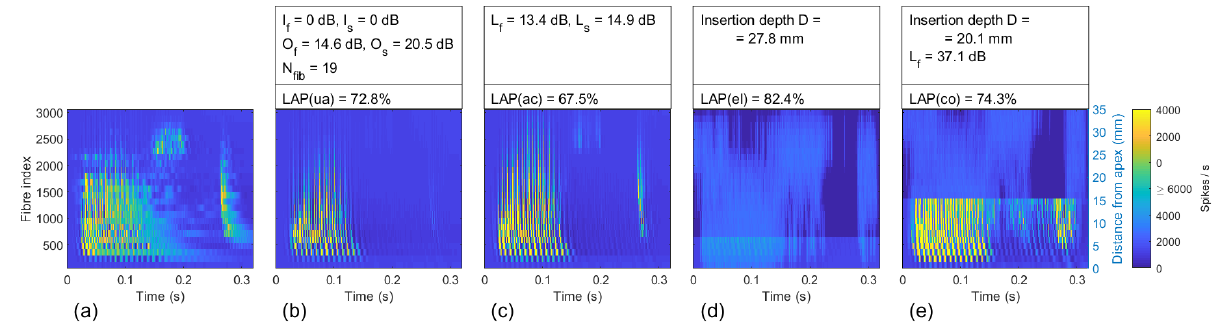
Figure 6. AN firing rates with regard to fiber index and time. The subject showed moderate CGL. See ( a ) Normal hearing reference. ( b ) Unaided hearing, with hearing loss parameters (I f , I s , O f , O s , and N fib ). ( c ) Sole acoustical amplification, with amplification parameters (L f and L s ). ( d ) Sole electrical stimulation, with insertion depth of the CI. ( e ) Electrical stimulation combined with acoustic amplification, with insertion depth of the CI and amplification parameter L f . LAP refers to the cost-adjusted loss of action